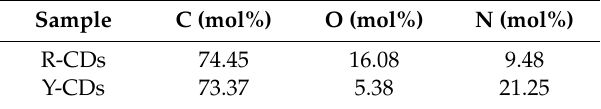
Table 2. XPS elemental analysis results of the R-CDs and